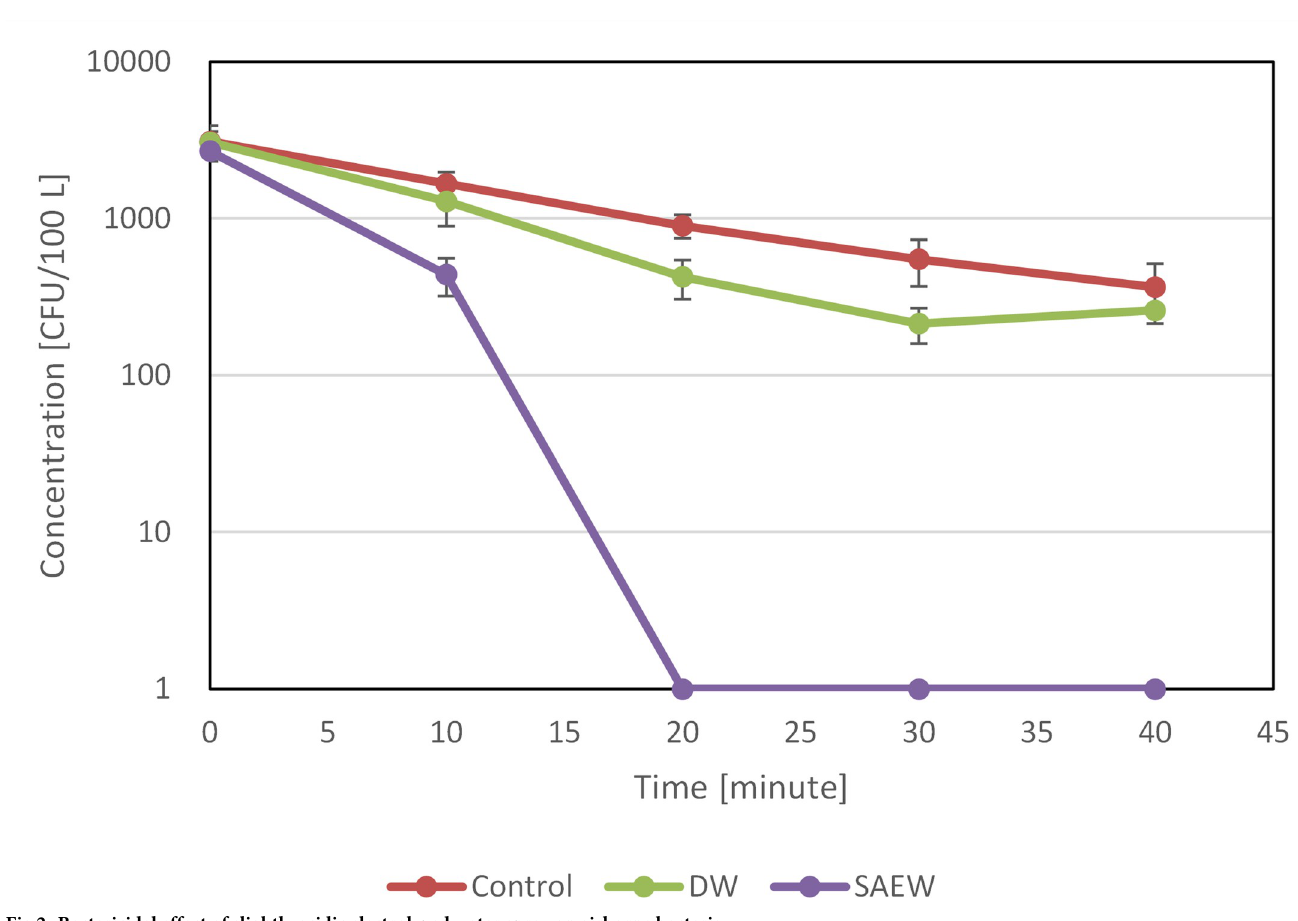
Fig 2. Bactericidal effect of slightly acidic electrolyzed water spray on airborne bacteria.